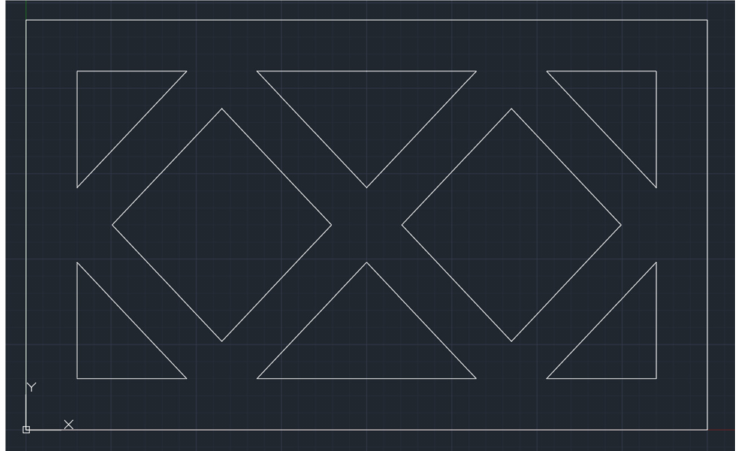
Figure 10. Model Mimicking typical WASP 3D-printed cob design [33].